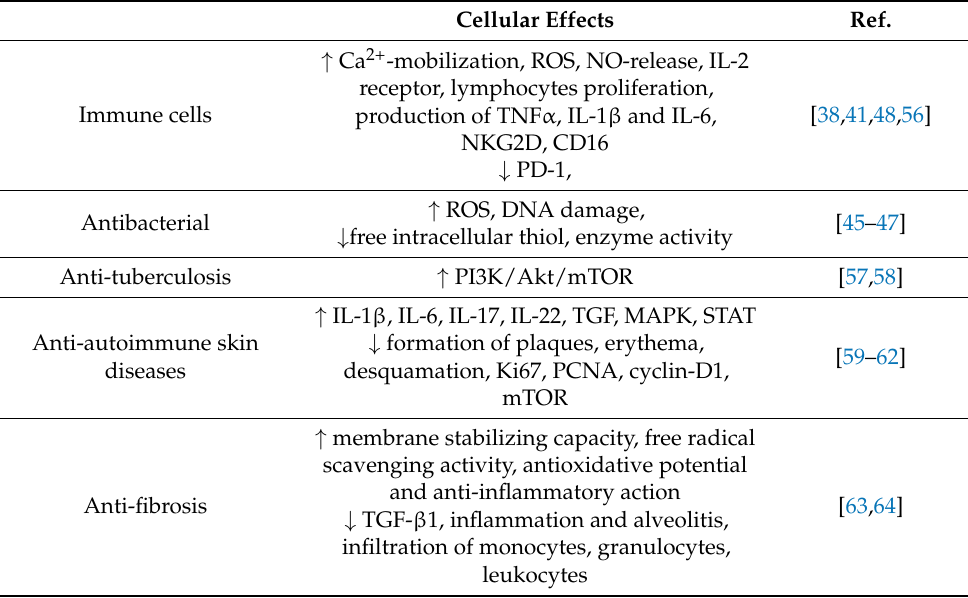
Table 1. Physiological effects of SeNPs associated with immunity